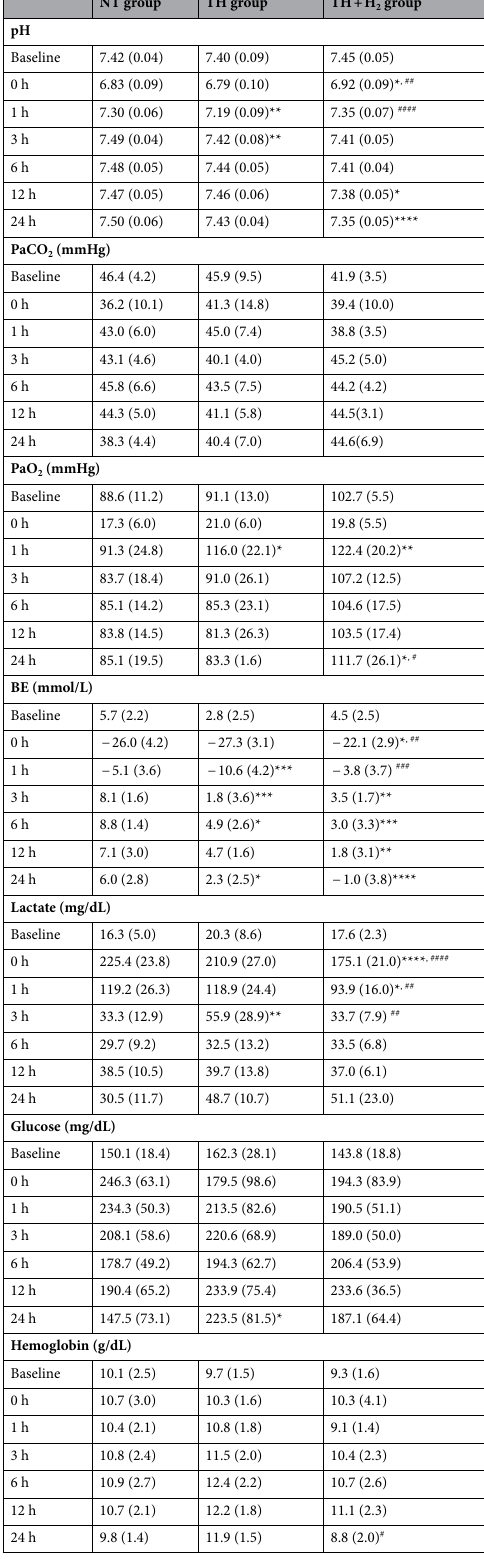
Table 1. Blood gas, lactate, glucose, and hemoglobin before, at the end of insult, and at 1, 3, 6, 12, and 24 h after insult in the NT, TH, and TH + H 2 groups. * p < 0.05, ** p < 0.01, *** p < 0.001, **** p < 0.0001 versus